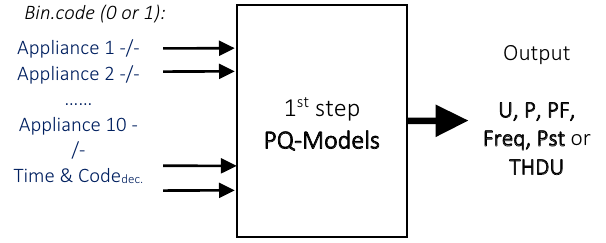
Figure 8. PQ-Modeling using binary coded load inputs in the 1st stage.